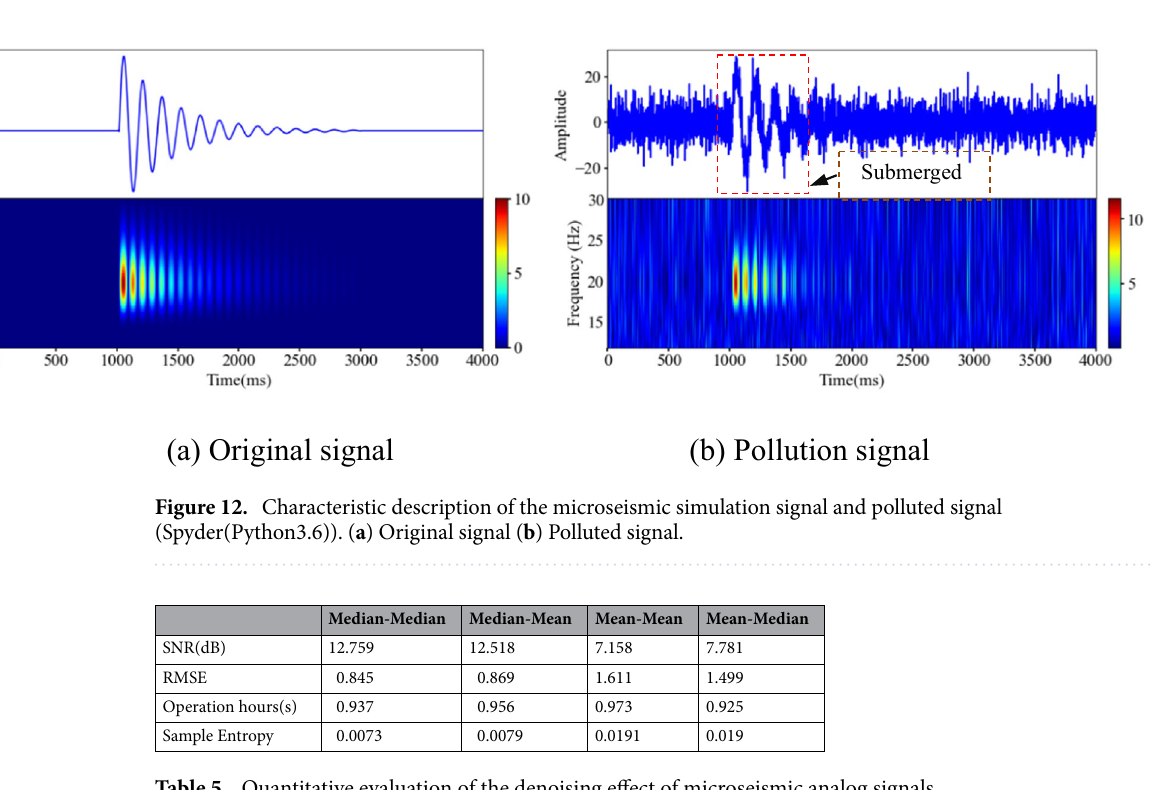
Table 5. Quantitative evaluation of the denoising effect of microseismic analog